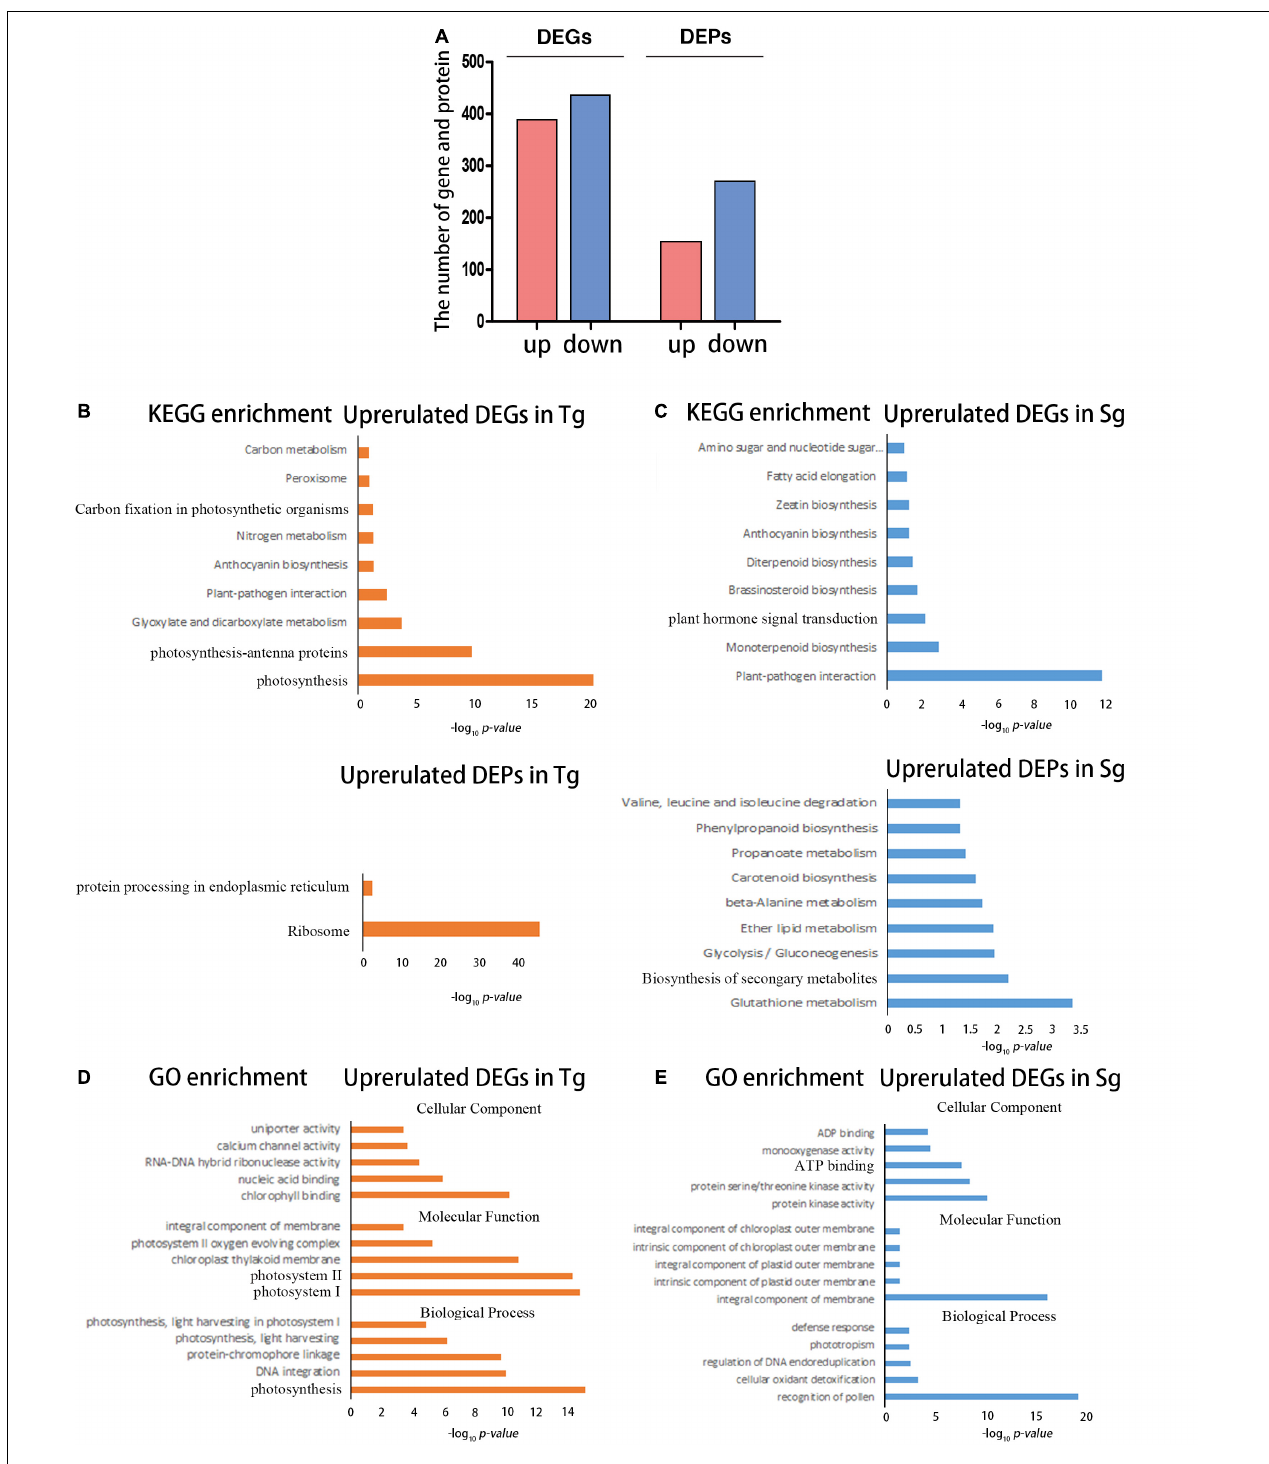
FIGURE 2 | The transcriptome and proteome reflecting the differences between Tg and Sg C. japonica under normal conditions. (A) Number of DEGs and DEPs under the control temperature conditions. (B) The bar chart shows the significantly enriched KEGG pathways for the highly expressed DEGs and DEPs in Tg C. japonica , The abscissa represents the -log 10 ( p ) value. (C) The bar chart shows the significantly enriched KEGG pathways for the highly expressed DEGs and DEPs in Sg C. japonica . The abscissa represents the -log 10 ( p ) value. (D) The plot shows the significantly enriched GO terms for higher expression of DEGs and DEPs in Tg C. japonica , and the abscissa represents -log 10 ( p ) value. (E) Plot shows the significantly enriched GO terms for the higher expression of DEGs and DEPs in Sg C. japonica . The abscissa represents -log 10 ( p ) value.